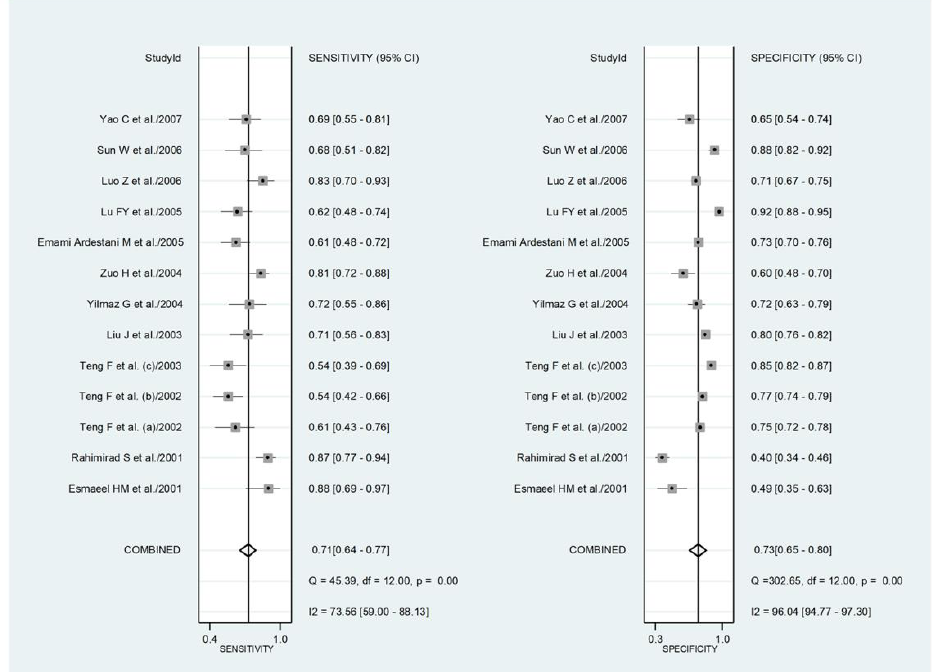
Figure 14. Forest plot for the pooled estimates of sensitivity and specificity of neutrophil-to-lymphocyte ratio values for predicting adverse outcomes. p = 0.00 indicates a p -value < 0.001.